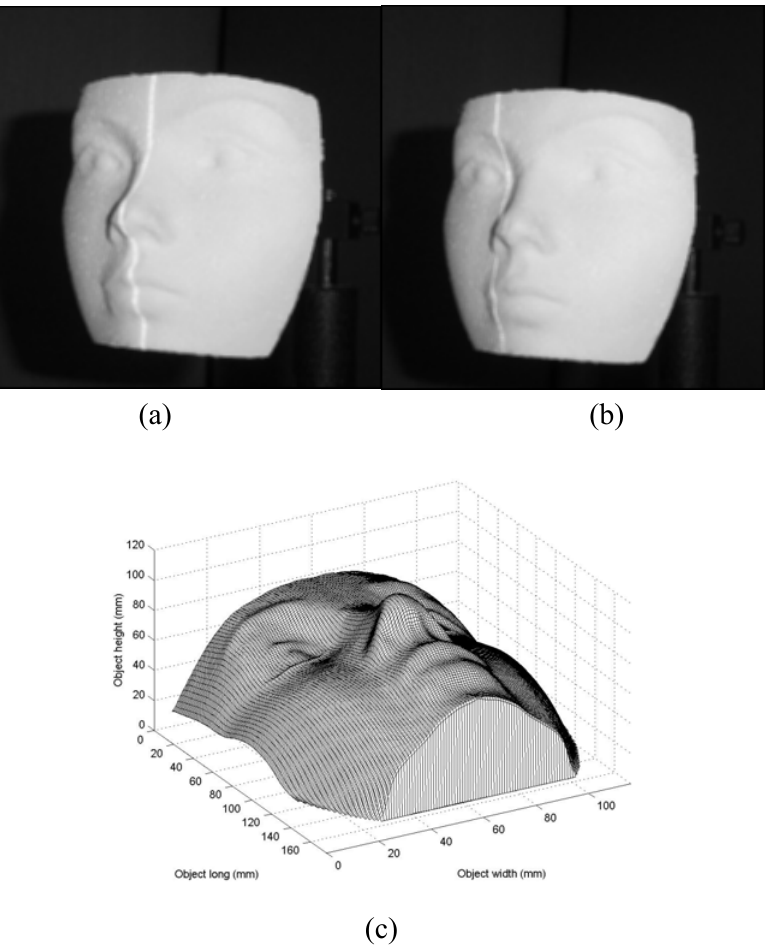
Figure 14. (a) Dummy face to be profiled. (b) Occlusion based on the broken line. (c) Three-dimensional shape of the dummy